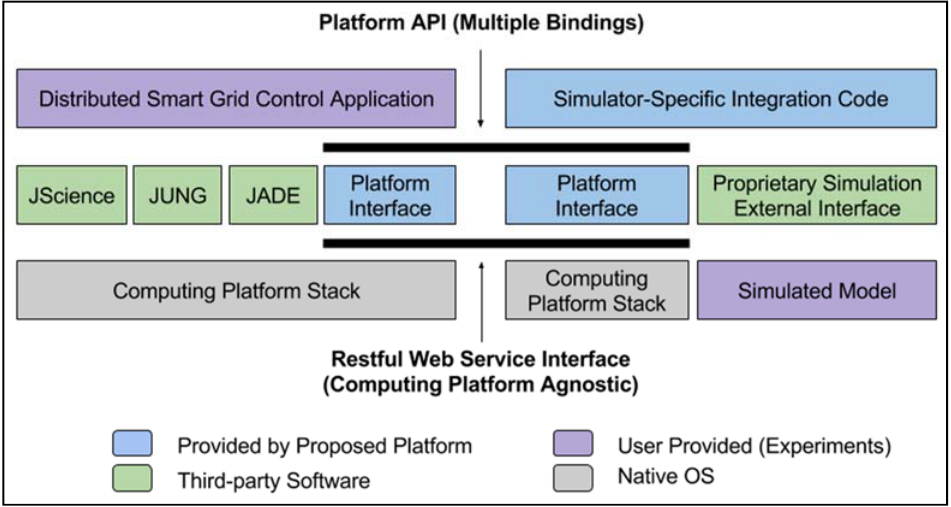
Figure 1. Platform Software Architecture.